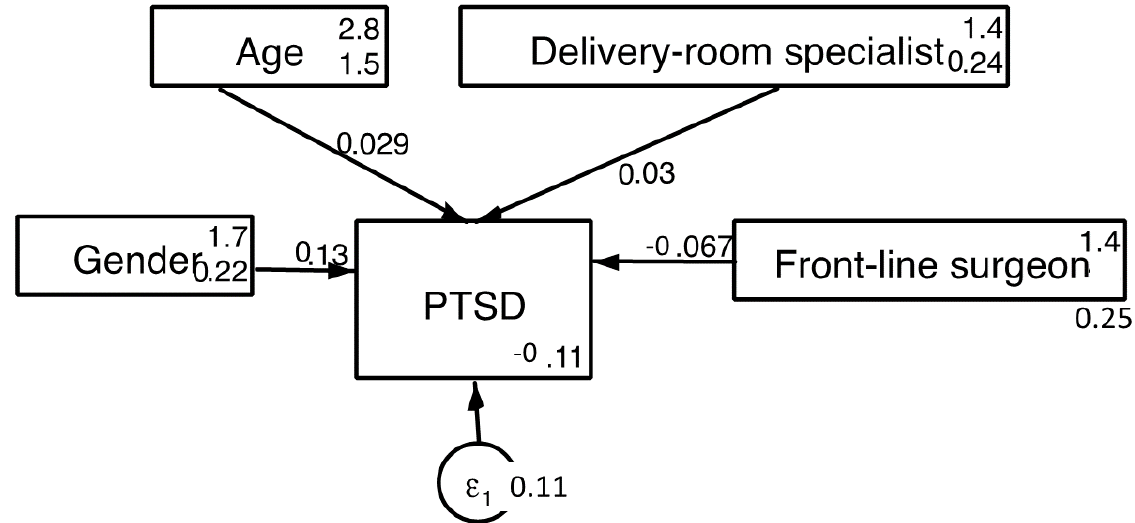
Figure 1. Predictive model for ITQ scores; PTSD, Post-traumatic stress disorder; Chi sq (baseline vs. saturated) = 6.588; p < 0.159; Population error RMSEA = 0.001 ( p < 0.05); Akaike’s information criterion = 1462.263; Bayesian information criterion = 1482.458; Comparative fit index = 1; Tucker–Lewis index = 1; Standardized root mean squared residual = 0.001; Coefficient of determination =